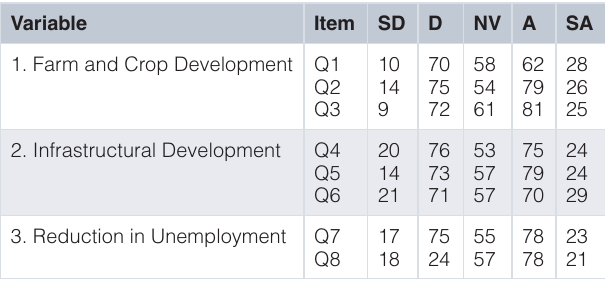
Table 2. Response to Items on Research Problem.